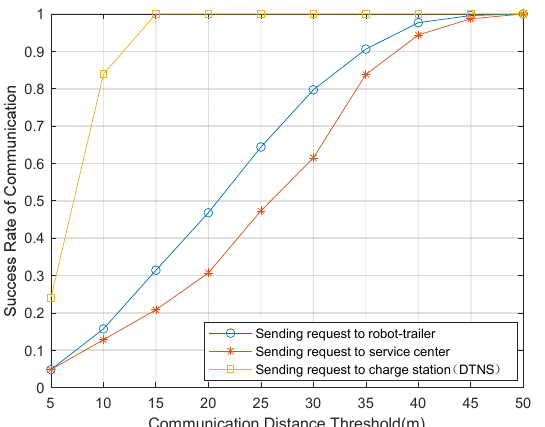
Figure 5. Comparison of success rates of communication when the charging stations are deployed in a fixed location.